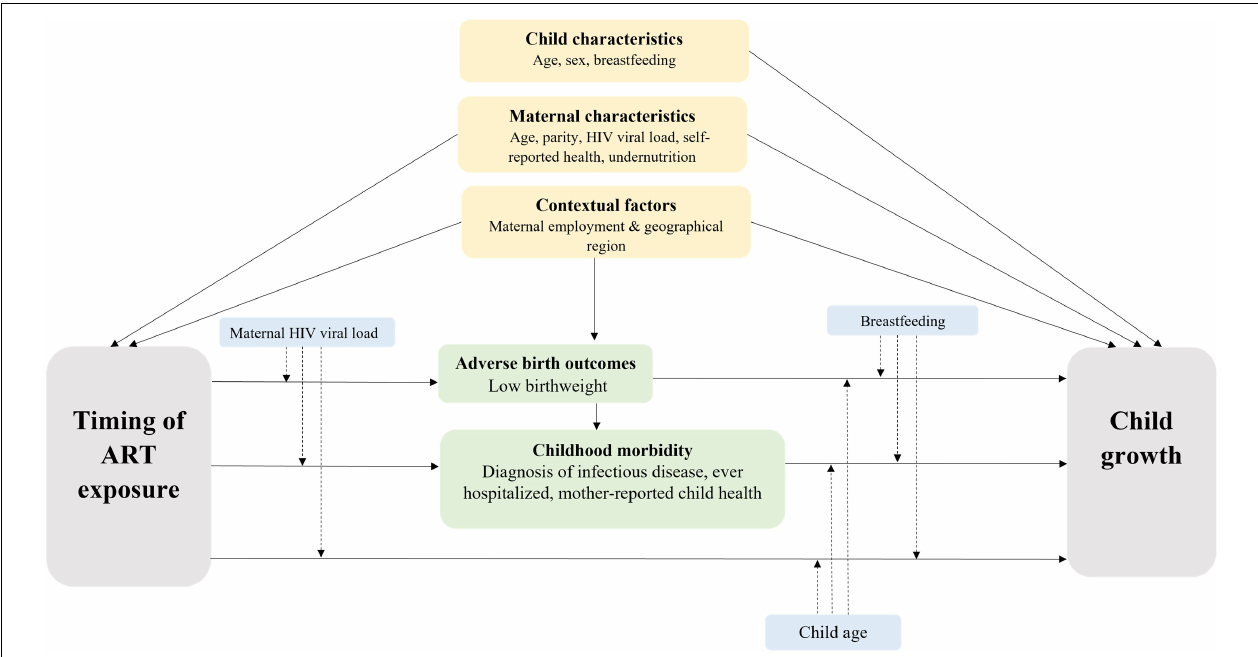
FIGURE 1 | Conceptual Framework. Grey boxes denote primary exposure and outcome; yellow boxes denote a priori confounders; green boxes denote potential mediators; dashed arrows from blue boxes denote potential effect